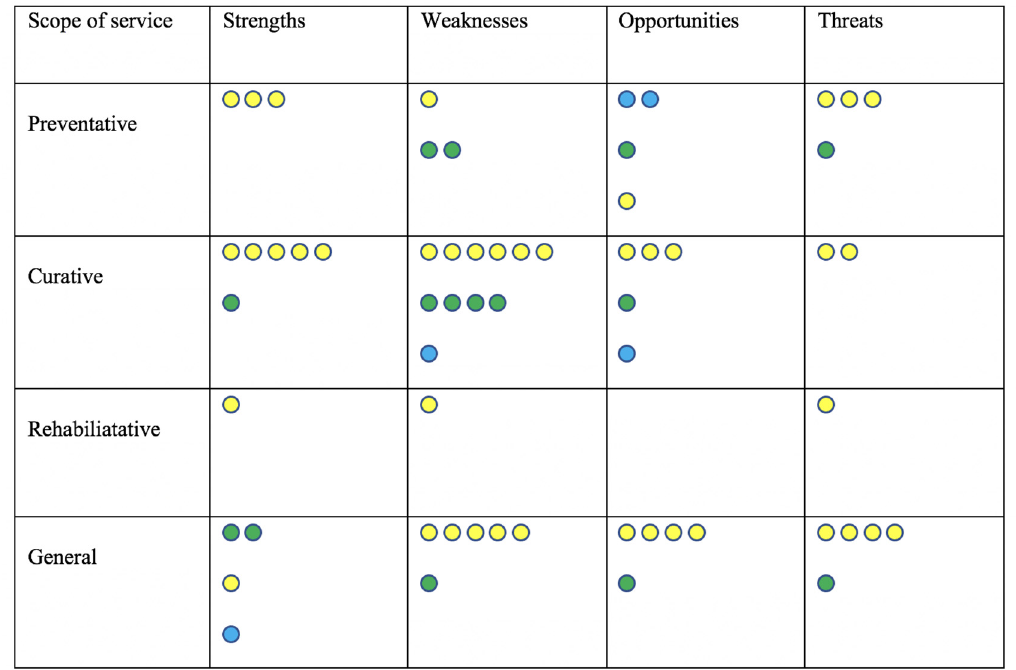
Figure 3. Visual map of type of articles/evidence. Preventative —Screening/Assessment/Triage/Lifestyle/Social connectedness; Curative —Treatment/Follow-up Rehabilitative —Physiotherapy; prosthetics management and bereavement support; General —No definitive focus; Green circles —Single studies/Case study; Blue circles —Literature and Scoping reviews; Yellow circles —Opinions/Reports/Editorials/Recommendations/Perspectives—Number of small circles represent the number of articles of specific type/category.